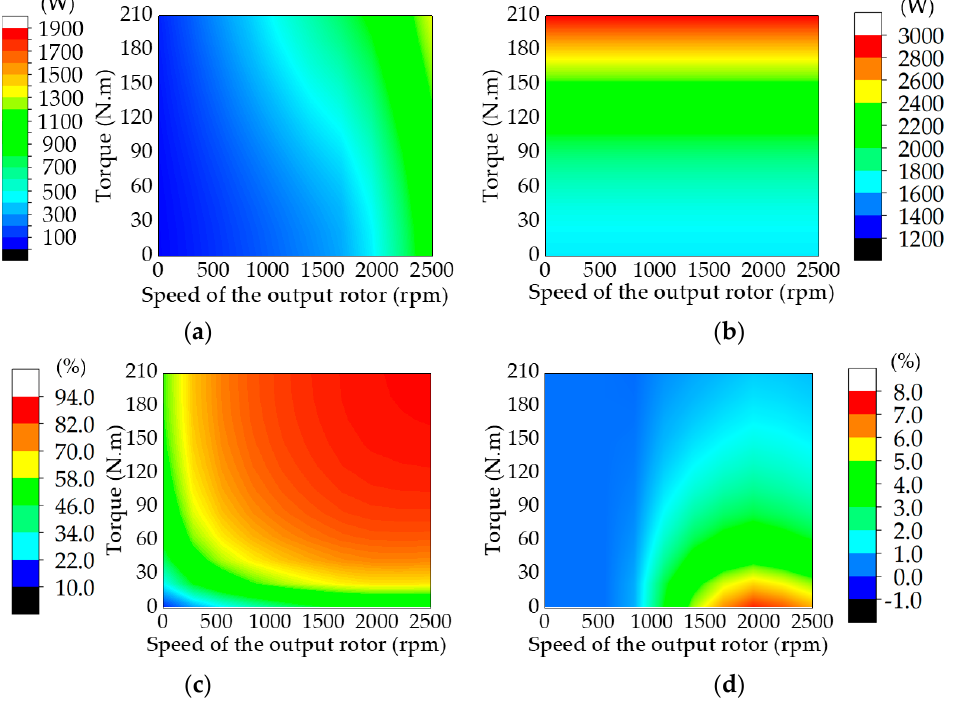
Figure 10. Loss and efficiency maps in the constant torque region according to the winding frequency when the amplitude of the inner winding current is adjusted and the outer winding current is fixed at the rated current (168 Arms). ( a ) Minimum iron loss map; ( b ) Copper loss map; ( c ) Maximum efficiency map; ( d ) Efficiency difference between Type III and Type I.